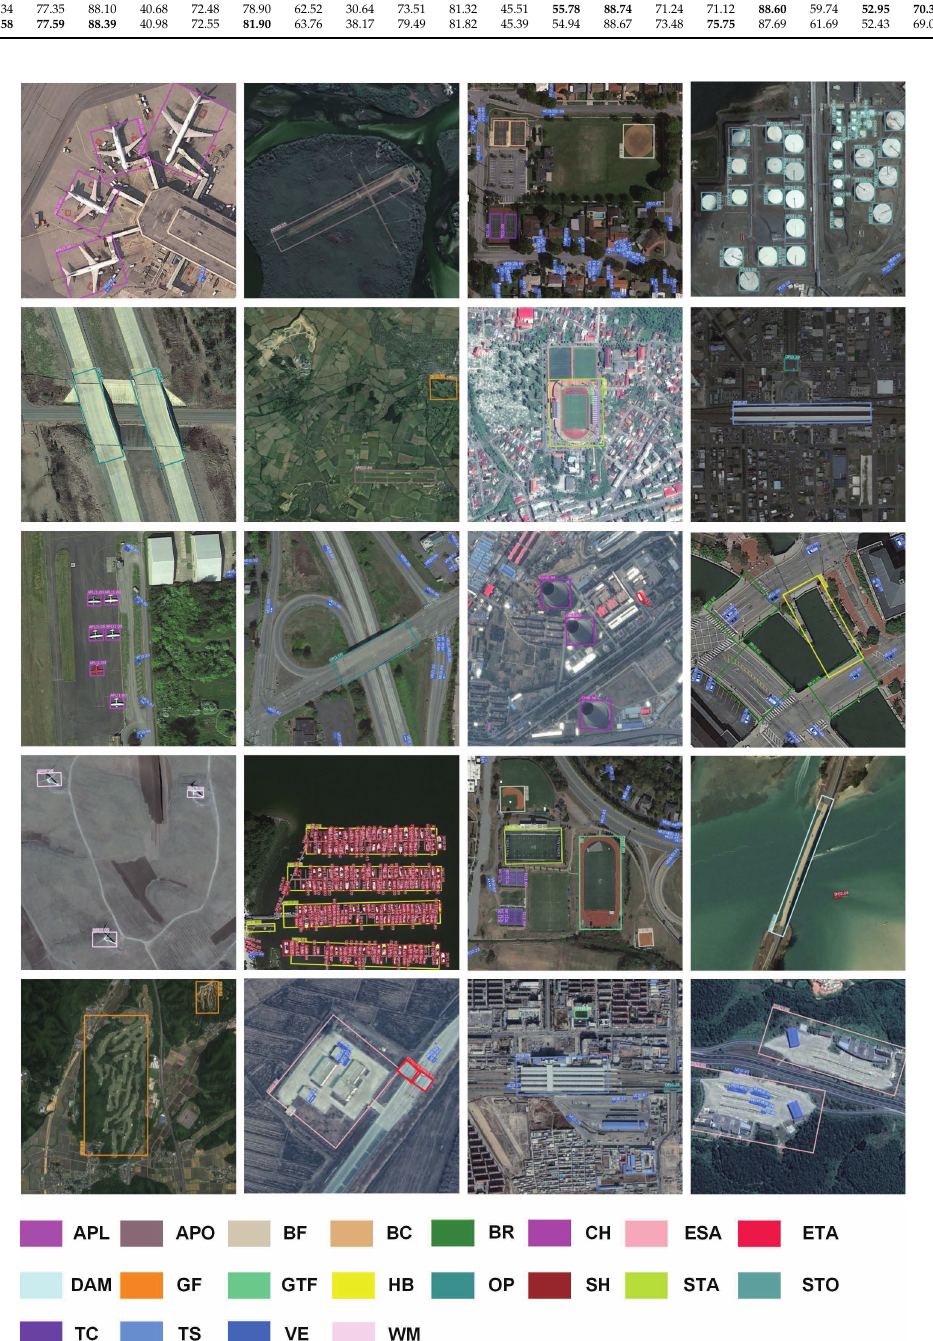
Figure 8. Depictions of the detection results on the DIOR-R dataset test set. We use bounding boxes of different colors to represent different